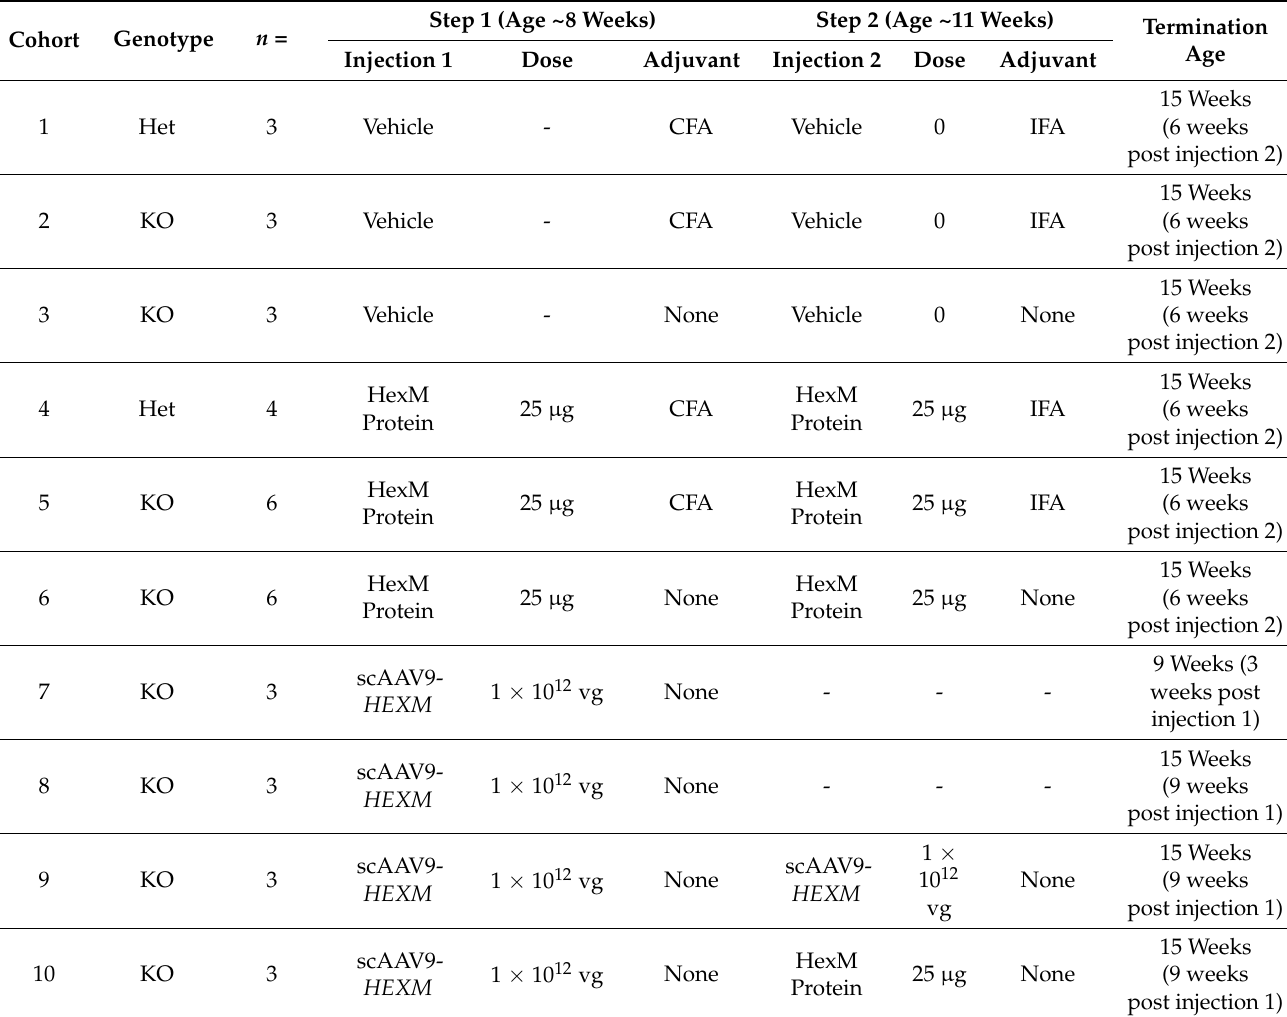
Table 2. Study design for SD mice, including genotype, number of mice, injections, and termination time points. Cohort